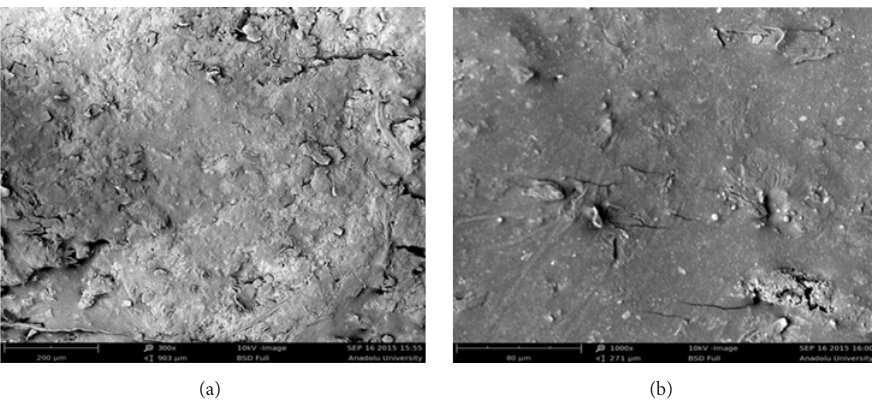
Figure 7: SEM images of PK-BTM30CW70 exposed to L-MSW: (a) 300x; (b)